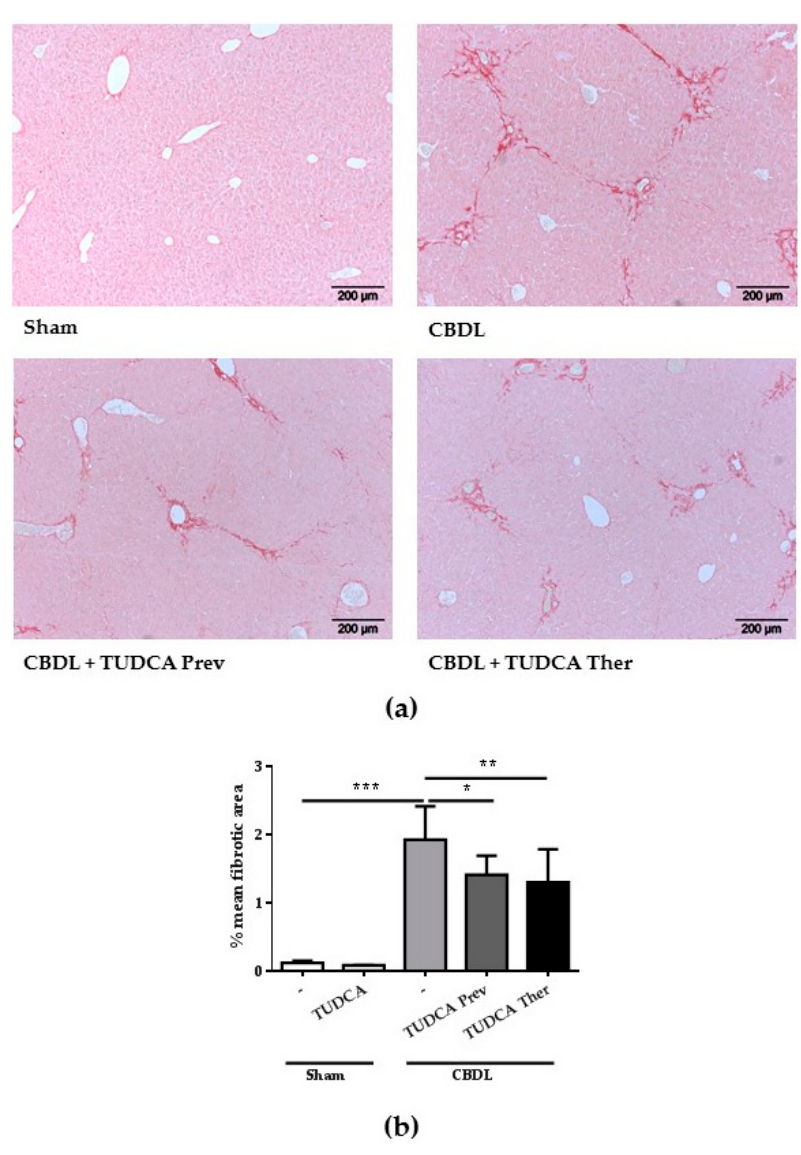
Figure 3. Treatment with TUDCA reduces the degree of liver fibrosis: ( a ) Representative histological images of livers from a sham mouse, a CBDL control and CBDL mice treated with TUDCA, stained with Sirius red. Original magnification 100×; ( b ) Computerized quantification of fibrosis scores (mean fibrotic area (%) ± SD). * p < 0.05, ** p < 0.01, *** p < 0.001.